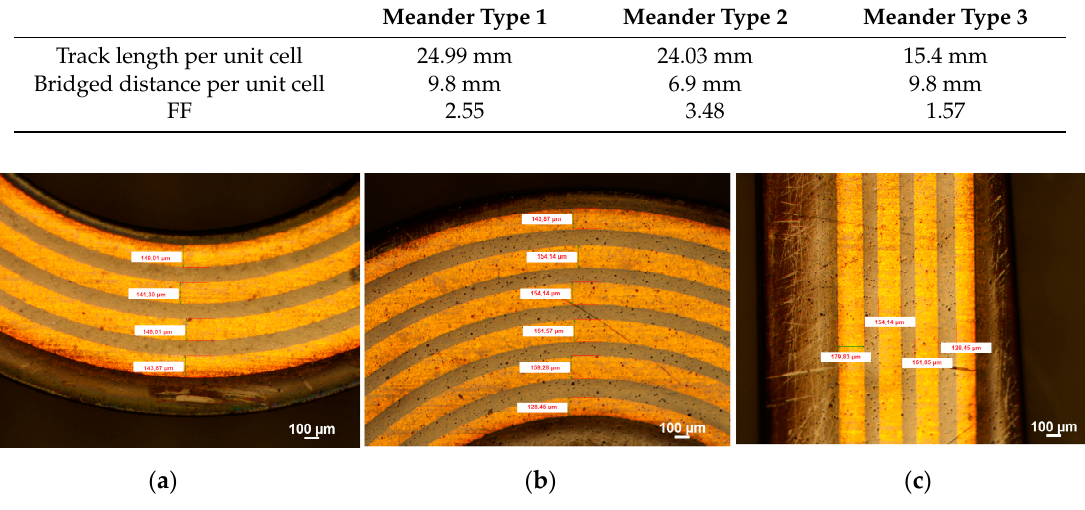
Figure 9. Comparison of copper track width on meander design 1 ( a ), meander design 1-1 ( b ) and meander design 1 middle part ( c ).